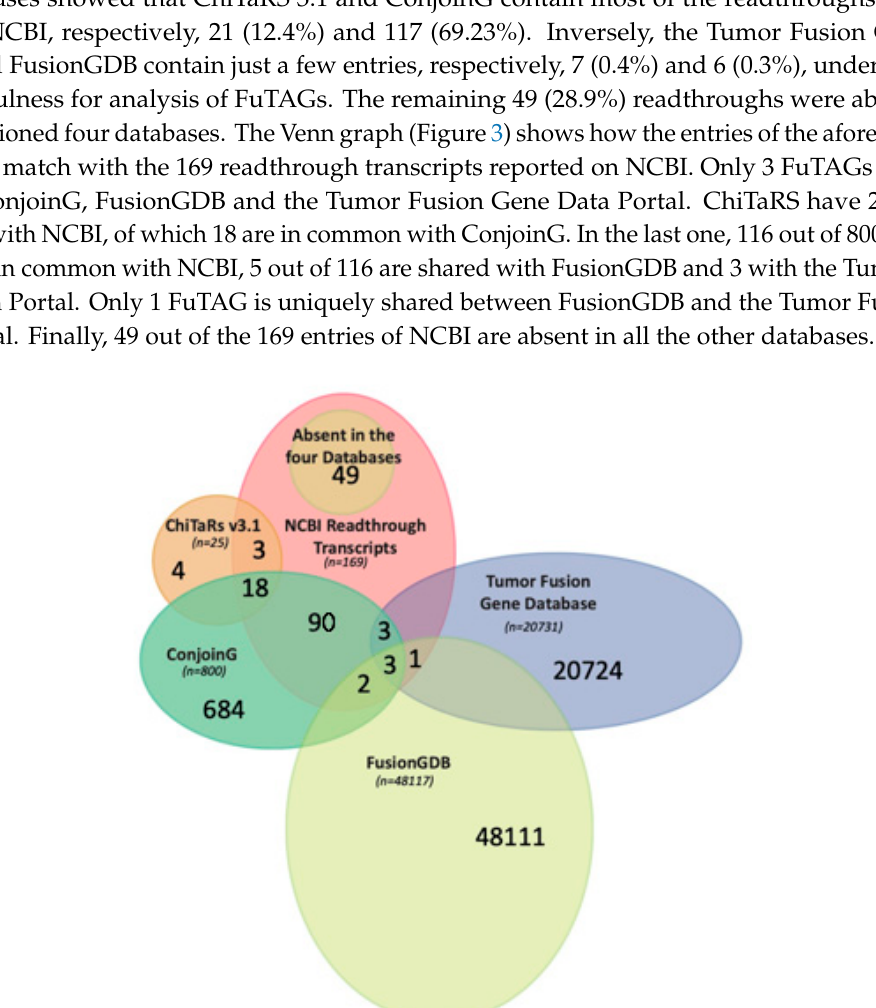
Figure 2. The timeline of five public databases collecting FuTAGs reports the year of publication, last update and number of FuTAGs compared to total records.